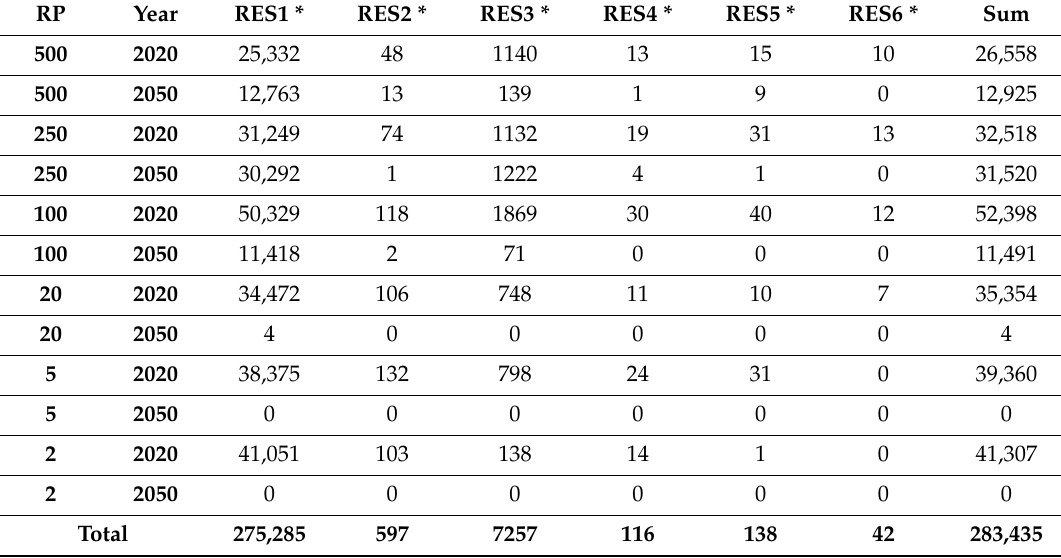
Table 1. The number of properties by residential occupancy type and the return period / year at which property start to flood. (Year / RP combinations of flood start in